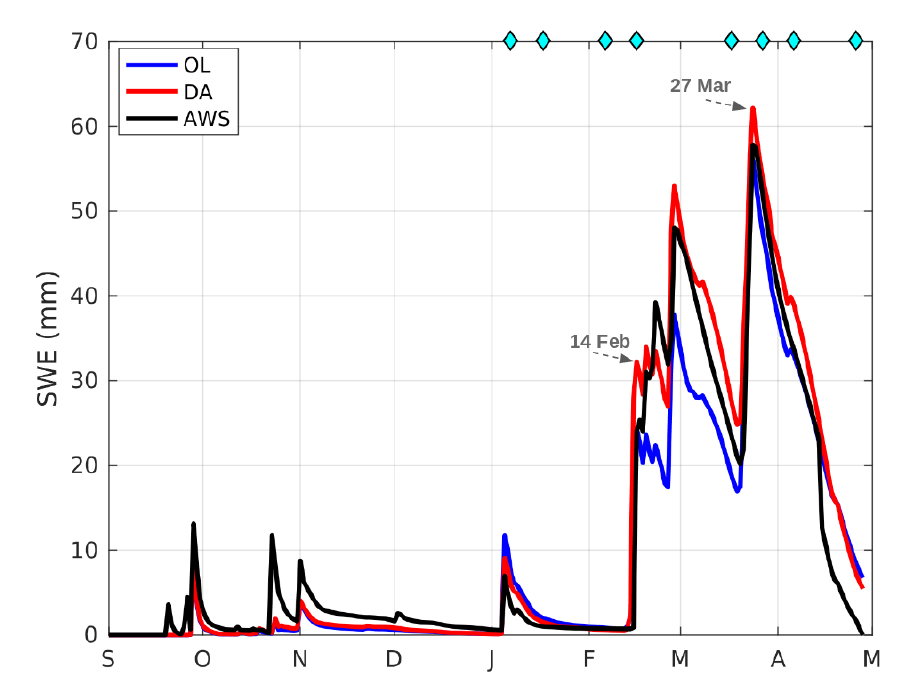
Figure 11. Comparison of open loop (OL), data assimilated (DA) and modeled SWE by using automatic weather stations (AWS).